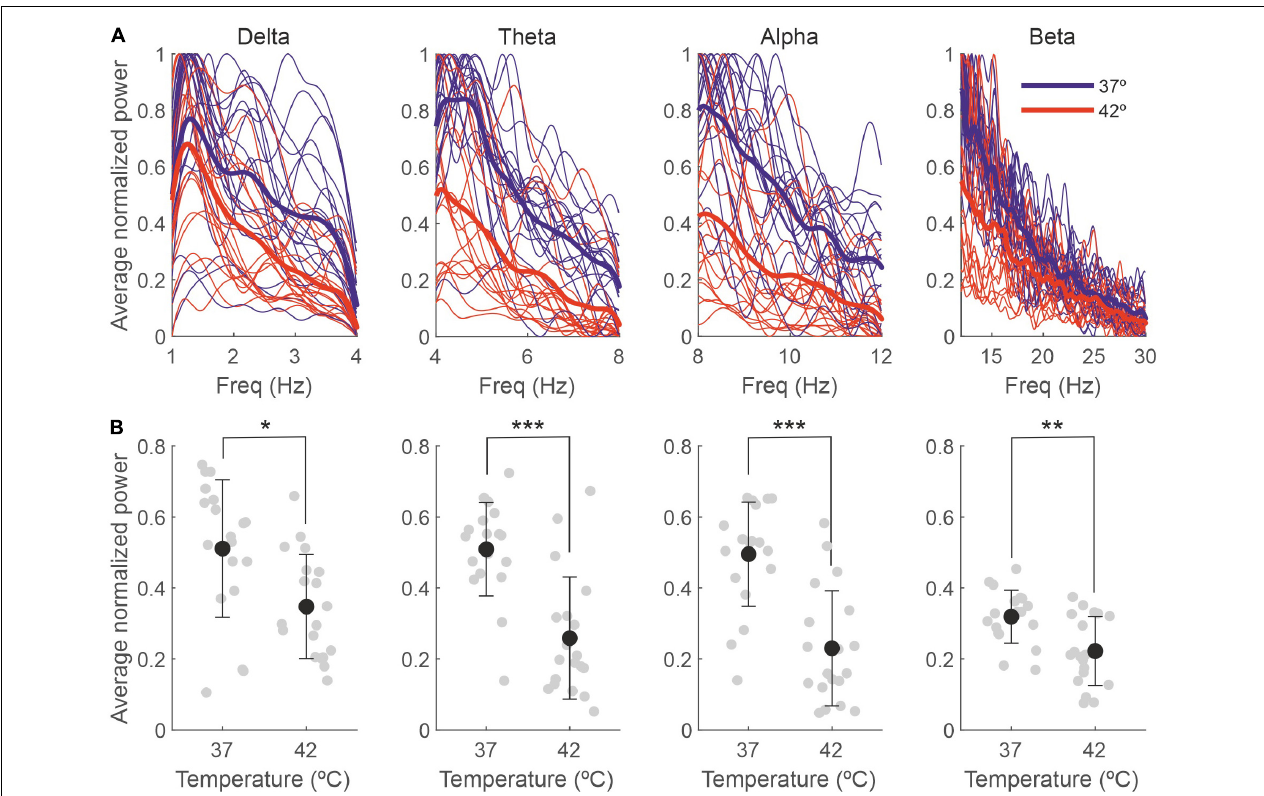
FIGURE 5 | The effect of the temperature on the EEG is due to changes in the delta, theta, alpha and beta bands. (A) Power spectra for different frequency bands for each individual recording session, normalized between 0 and 1 and averaged across 5-s bins (thin lines) and averaged across sessions (thick lines). (B) Power averaged across frequencies of the spectra in panel (A) . Gray dots represent individual sessions ( n = 19), and black dots represent the average across sessions (mean ± SD). * p < 0.01; ** p < 0.005; *** p <